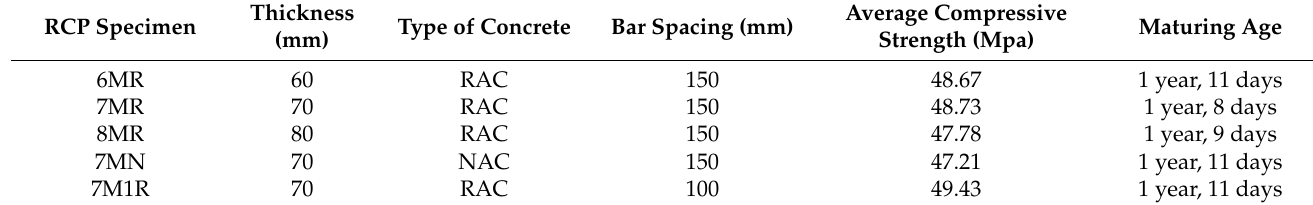
Table 5. Summary of RCP specimen.